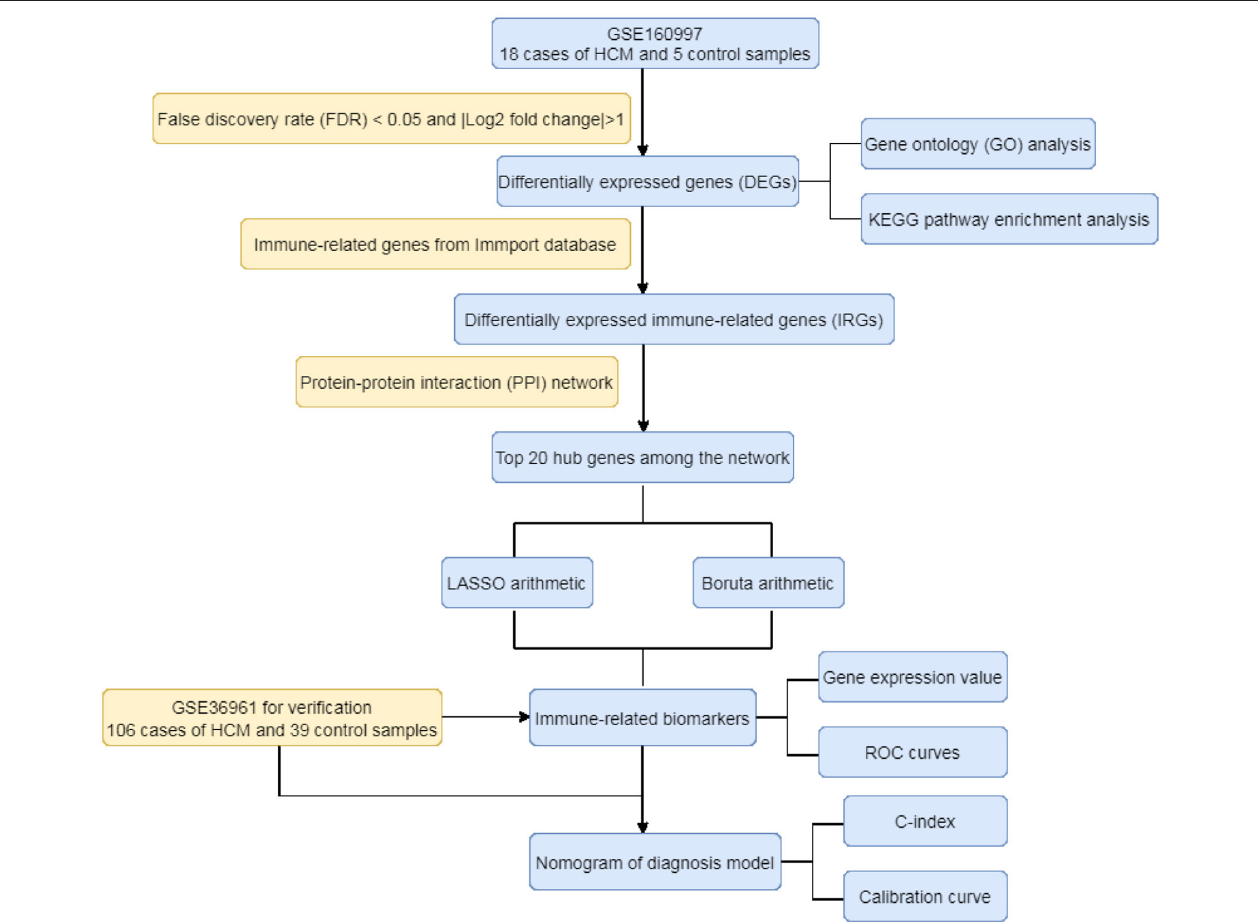
FIGURE 1 | The flowchart of the